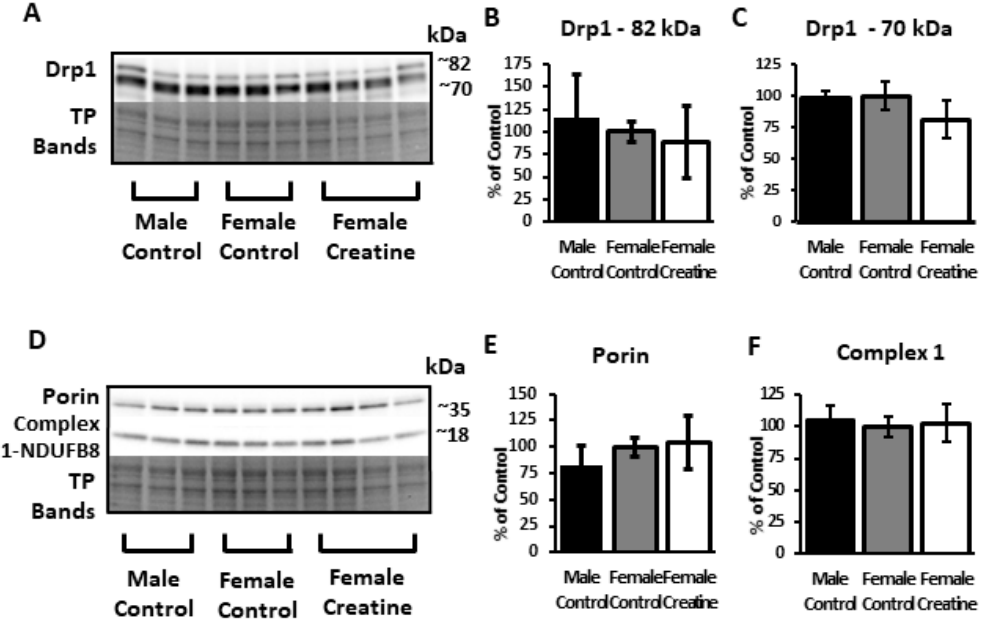
Figure 9. Relative hippocampal levels of mitochondrial proteins in control and Cr-supplemented 3xTg mice. Representative Western blots detecting ( A ) Drp1 (82 kDa and 70 kDa bands), ( D ) porin, and NDUFB8, a subunit of the electron-transport chain protein Complex I. Total protein (TP) was measured with Ponceau S staining (representative bands shown to indicate sample loading). Bar graphs ( B , C , E , F ) depict densitometry values after normalizing to total protein bands and are expressed as the percentage change from female control-fed means (100%) ± SD. ANOVA: n = 3–4.